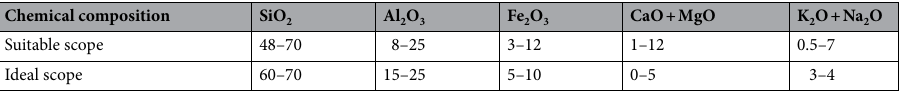
Table 1. Chemical composition appropriate for the production of ceramsite (%). The data in the table is obtained by XRD (Ultima IV, Rigaku, Japan).